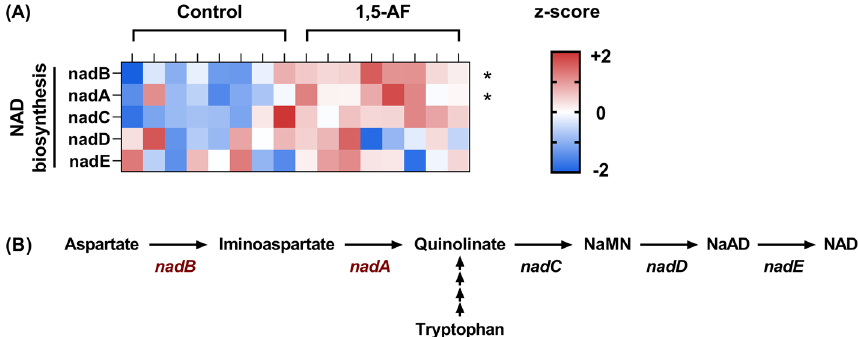
Figure 3. Genes associated with NAD biosynthesis were enriched in the gut microbiota of mice supplemented with 1,5-AF. ( A ) Relative gene abundances (z-scores) in NAD biosynthesis are shown; red and blue indicate high and low abundances, respectively. nad: nicotinamide adenine dinucleotide. *P < 0.05, determined by White’s non-parametric t -test with FDR adjustment for multiple comparison. ( B ) Schematic diagram of biosynthesis of NAD is shown. The genes encoding enzymes involved in the first two steps of the de novo synthesis of NAD from aspartate, were significantly enriched in the mice supplemented with 1,5-AF. NaMN: nicotinic acid mononucleotide. NaAD: nicotinic acid